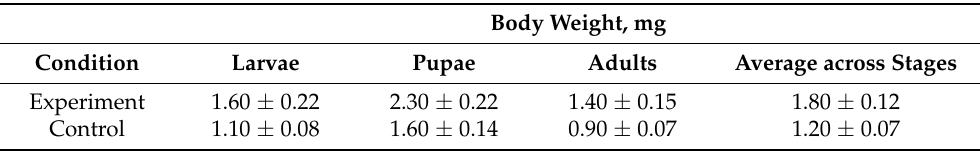
Table 1. Average body weight of mosquitoes at different life stages in control and experimental conditions (mean ± standard deviation).